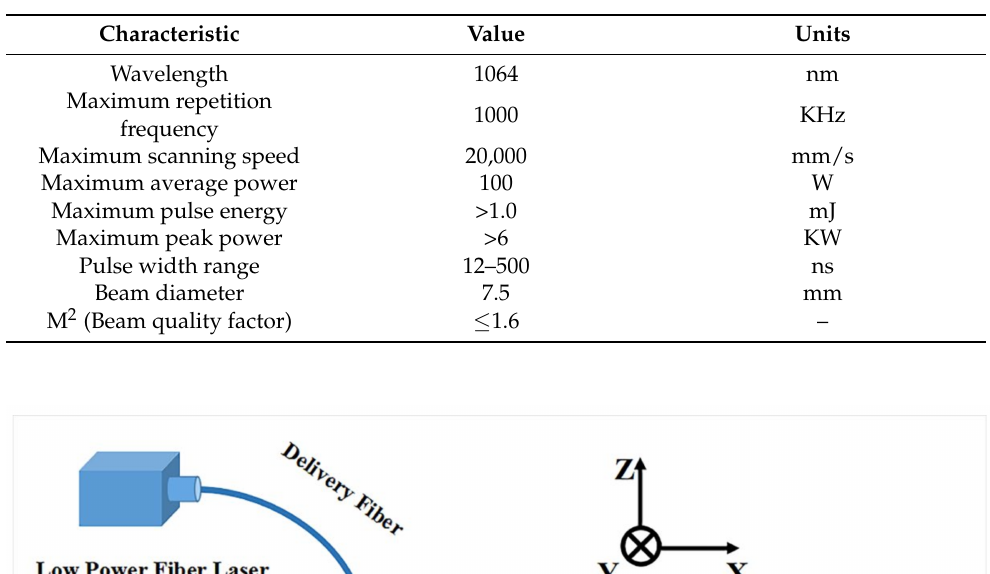
Table 2. Laser processing parameters.